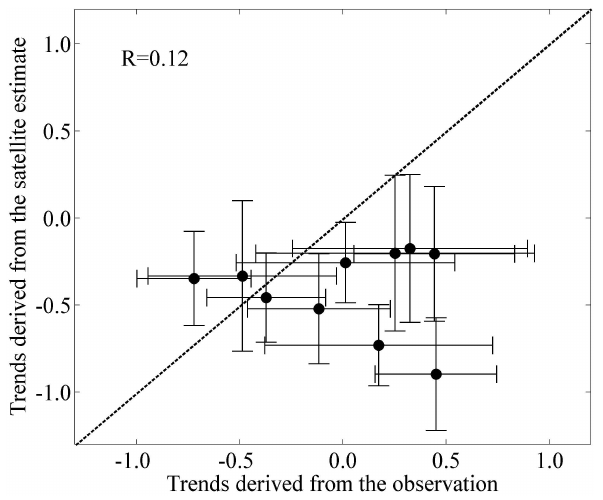
Fig. 9. Comparison of radiation trend slopes during 1984 ∼ 2006 between the observation and the GEWEX-SRB product at ten val- idation stations. The filled black circles denote trend slopes, and the bars denote the 95% confidence intervals of the estimated trend slopes. The unit of the trend is Wm − 2 yr − 1